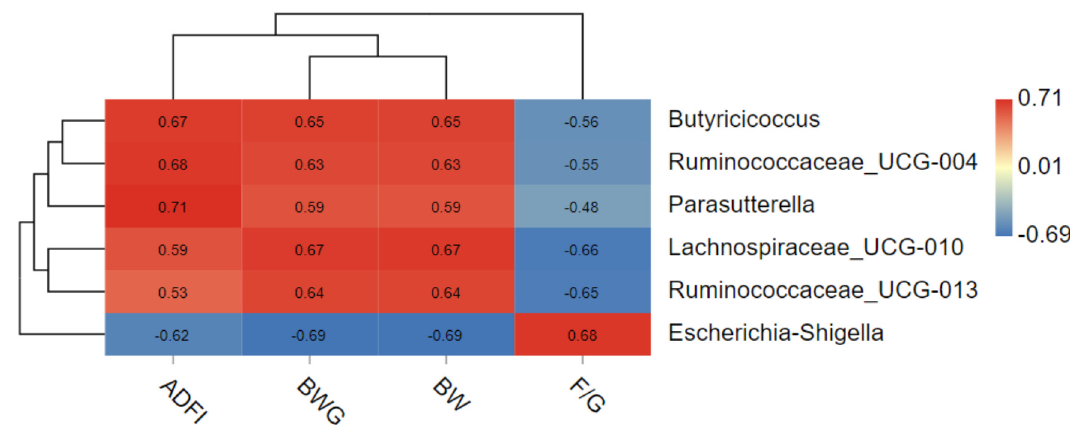
Figure 6. Correlation analysis of growth performance (ADFI, BWG, BW, F/G) and 6 indicator species.* 0.01 < p ≤